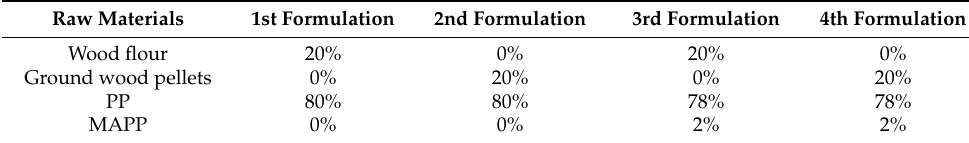
Table 1. Four different raw materials’ formulations of WPCs for each wood